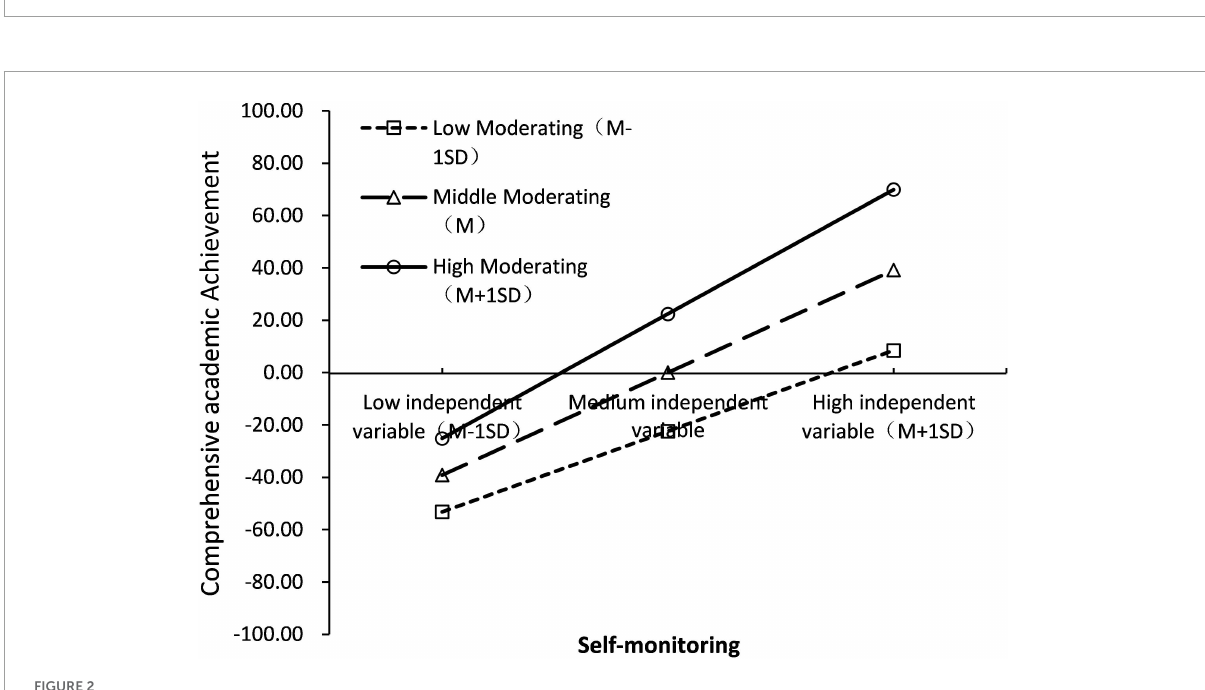
FIGURE2 Simple slope test (model